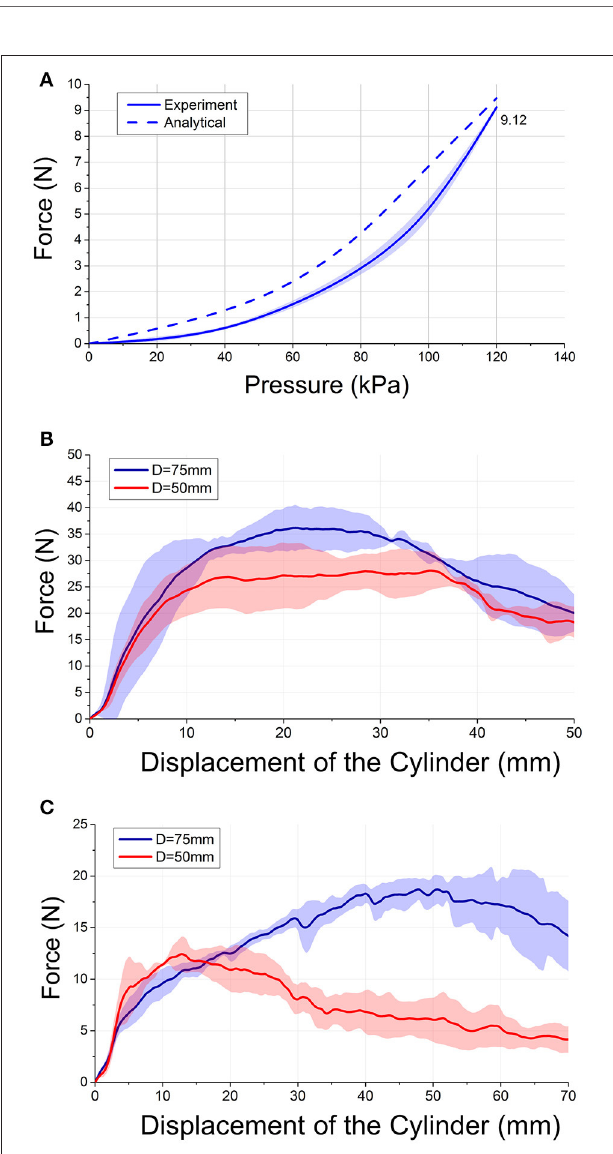
FIGURE 6 | (A) Experimental and theoretical blocked tip force values over increasing pressures. (B) Normal and (C) frictional grip force output-displacement of the cylinder relationships of four actuators gripping cylinder with diameter D = 75mm and D = 50mm at a fixed pressure